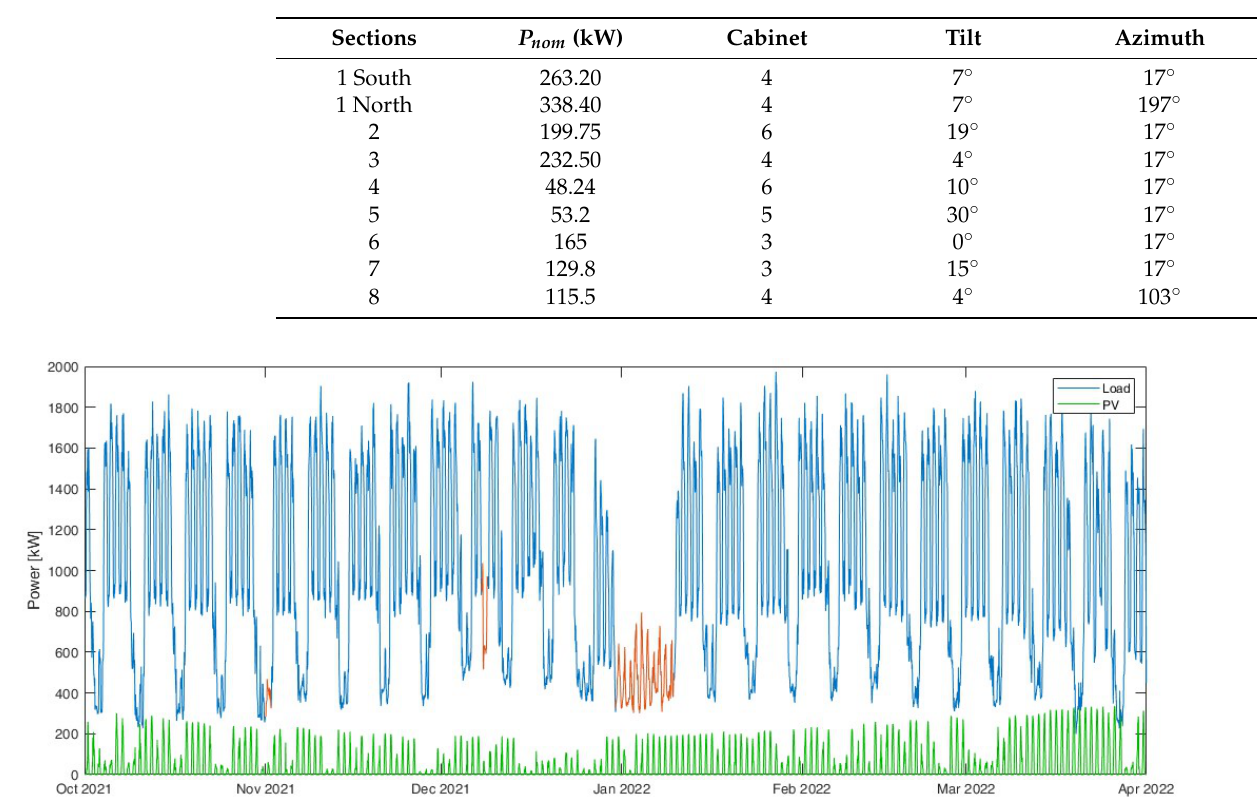
Figure 4. Power profiles used as input for the data processing phase. In blue, the total load absorbed by the analysed company; in red, the holidays that should be eliminated in the analysis; and in green, the photovoltaic power